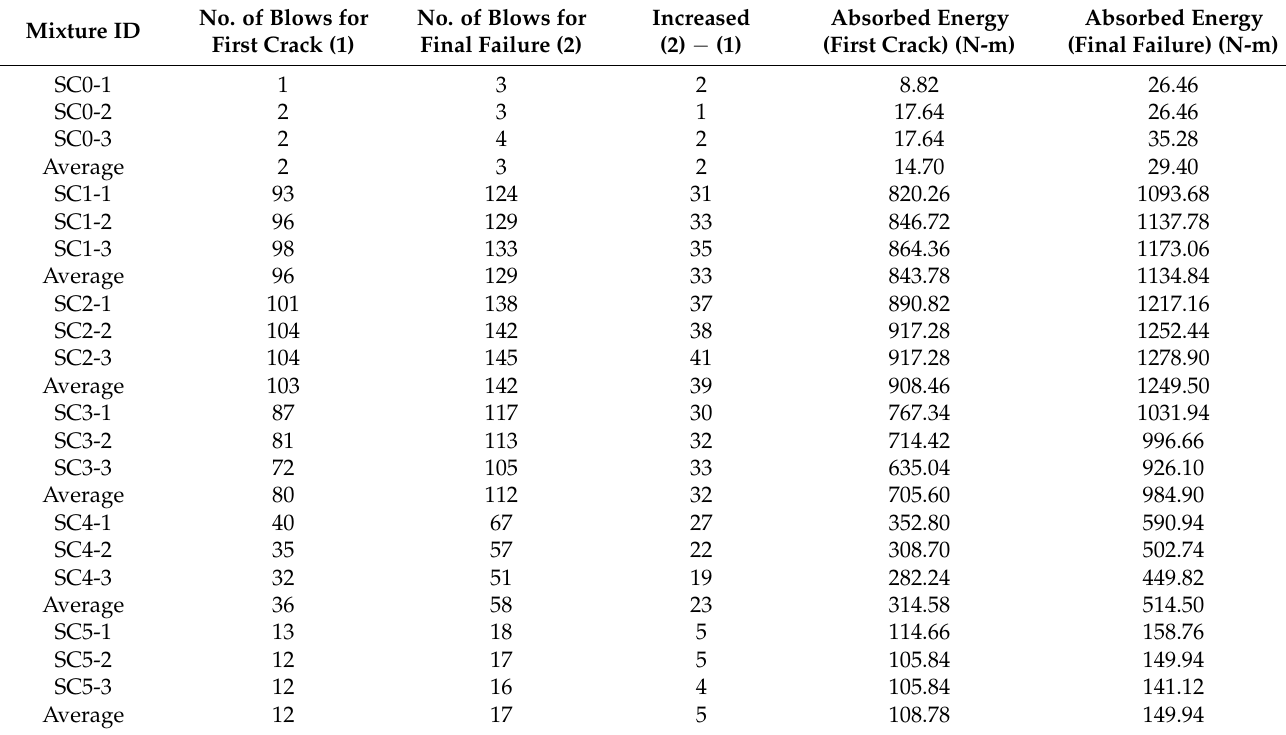
Table 6. Results obtained from the impact resistance